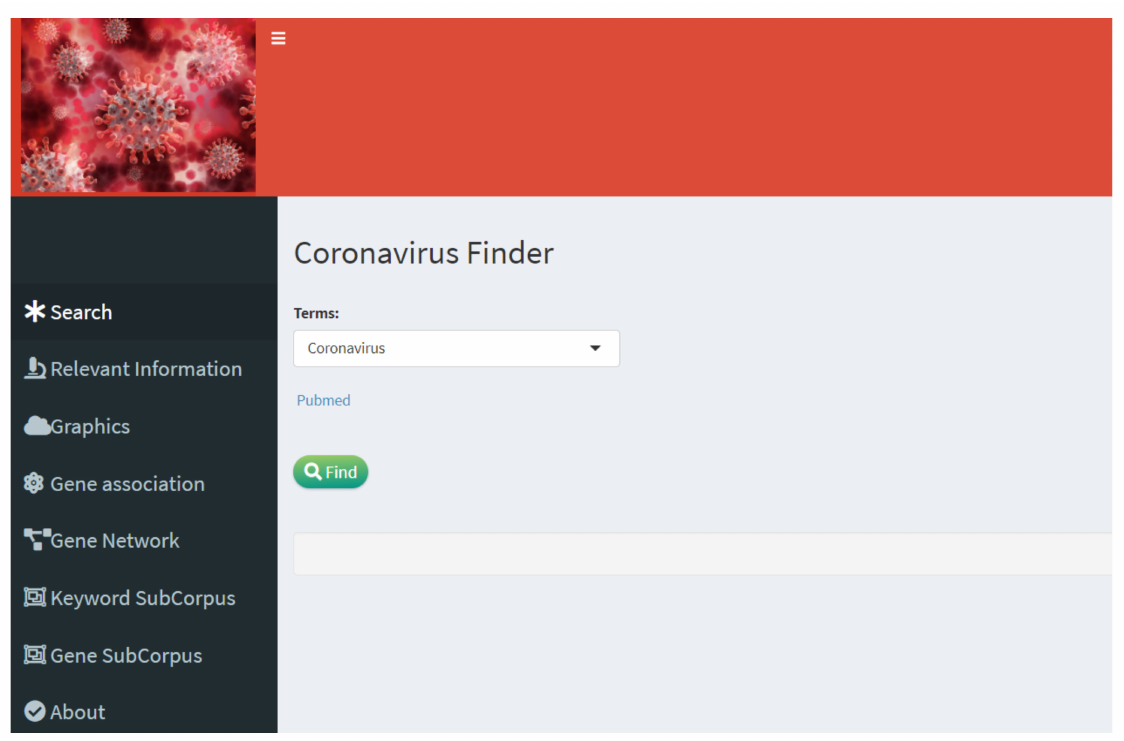
Figure 2. Front-end and menu of the interactive web application, named Coronavirus